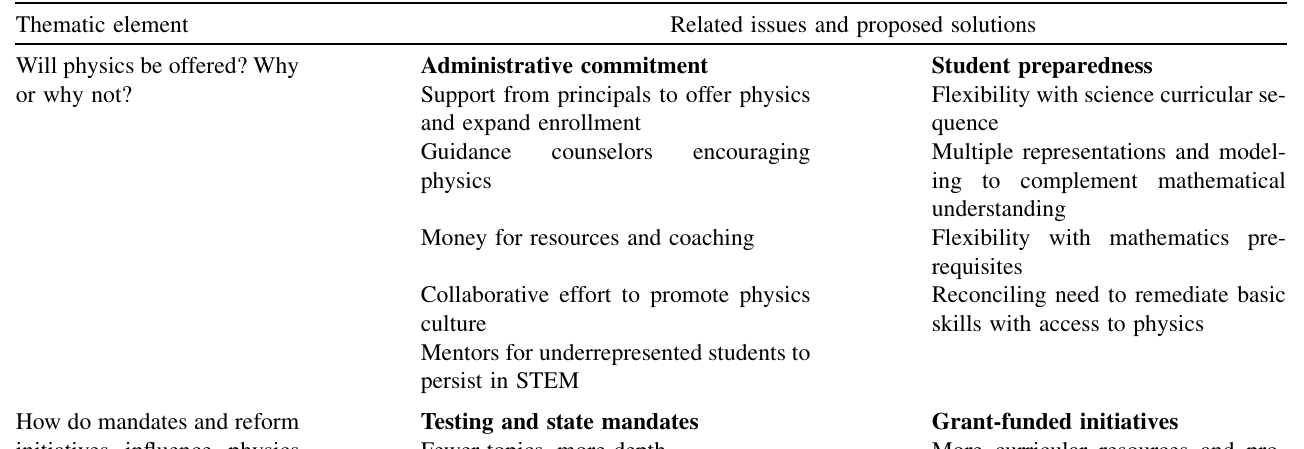
TABLE II. Summary of research findings on urban physics